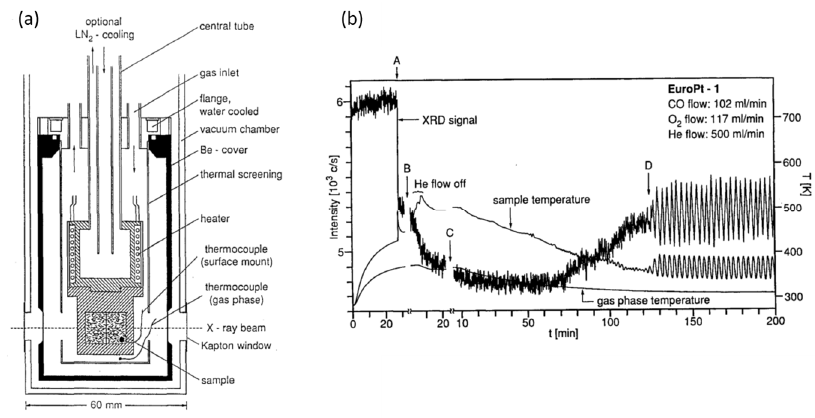
Figure 1. ( a ) Schematic of the apparatus used in [92] to permit in situ laboratory based time resolved X-ray diffraction measurements of a Pt/SiO 2 catalyst. The label (A) indicates the point where catalytic ignition occurs, (B) indicates the point where the He flow was stopped. ( b ) Temporal evolution of the catalysts as observed from the viewpoint of the integral intensity of the Pt(111) Bragg reflection from the SiO 2 supported nanoparticles. Reproduced with permission from Catal. Letts. 1994 , 28 , 373–381 [92]. Copyright 1994, Springer International Publishing AG.